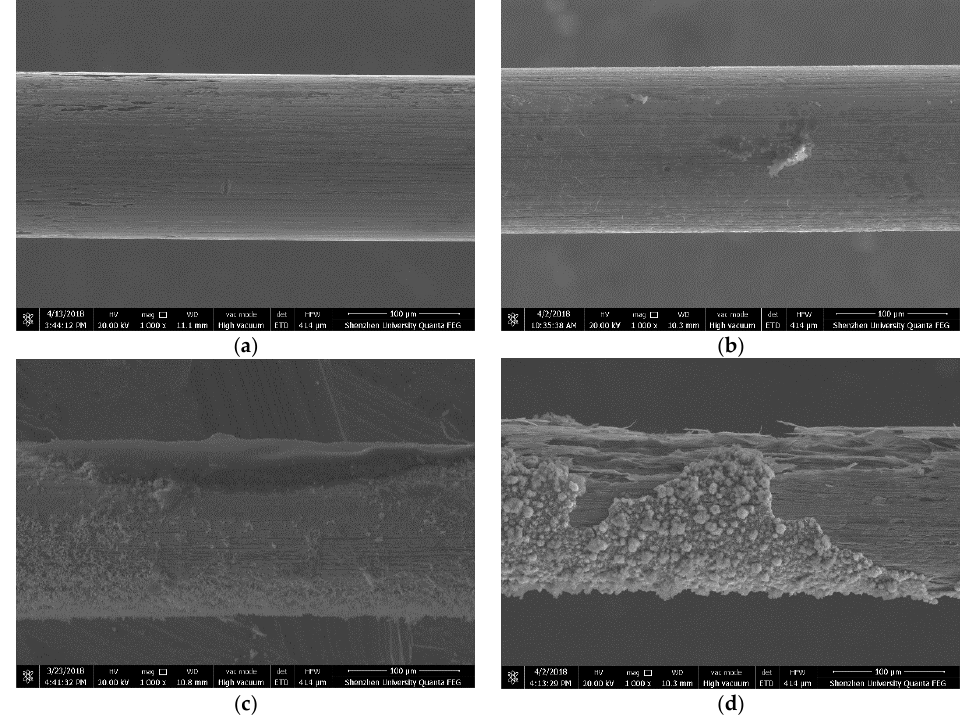
Figure 15. SEM images of corroded steel wires, ( a ) without passivation, ( b ) 1-day passivation, ( c ) 7-day passivation, and ( d ) 11-day passivation. Materials 2020 , 13 , x FOR PEER REVIEW